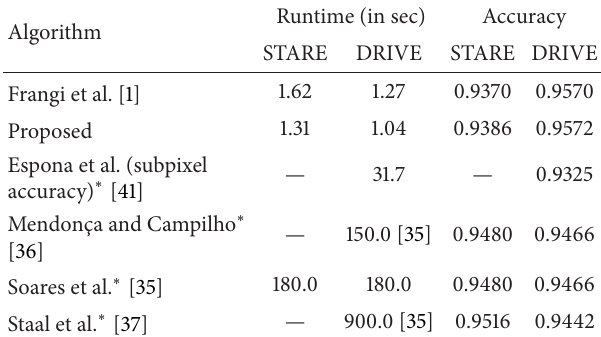
Table 3: Sensitivity (Se), specificity (Sp), and accuracy (Acc) of the methods measured on the STARE [32] database. The proposed modifications improved both the sensitivity and accuracy of the Frangi method.